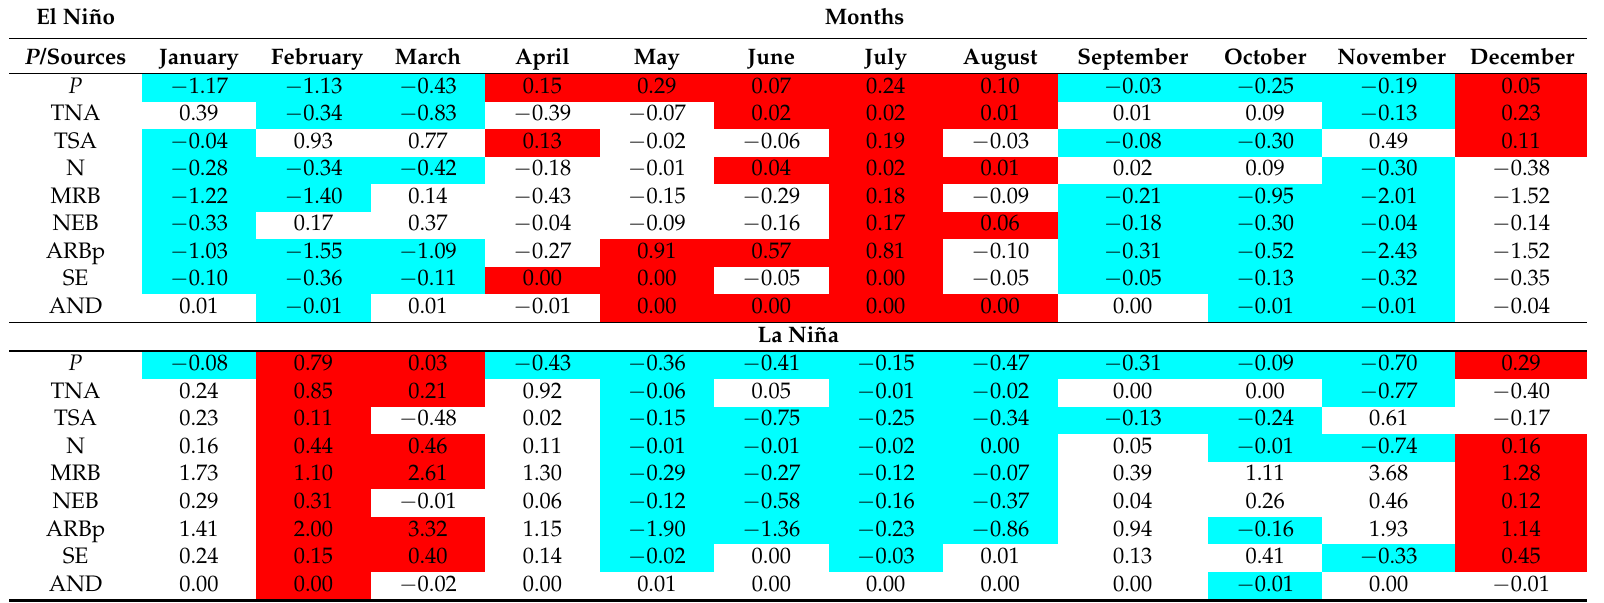
Table 6. Anomalies of P and |( E − P ) i10 < 0| over the MRB for composited of months under El Niño and La Niña conditions. Simultaneous negative (positive) anomalies of P and |( E − P ) i10 < 0| are shaded in blue (red). Period